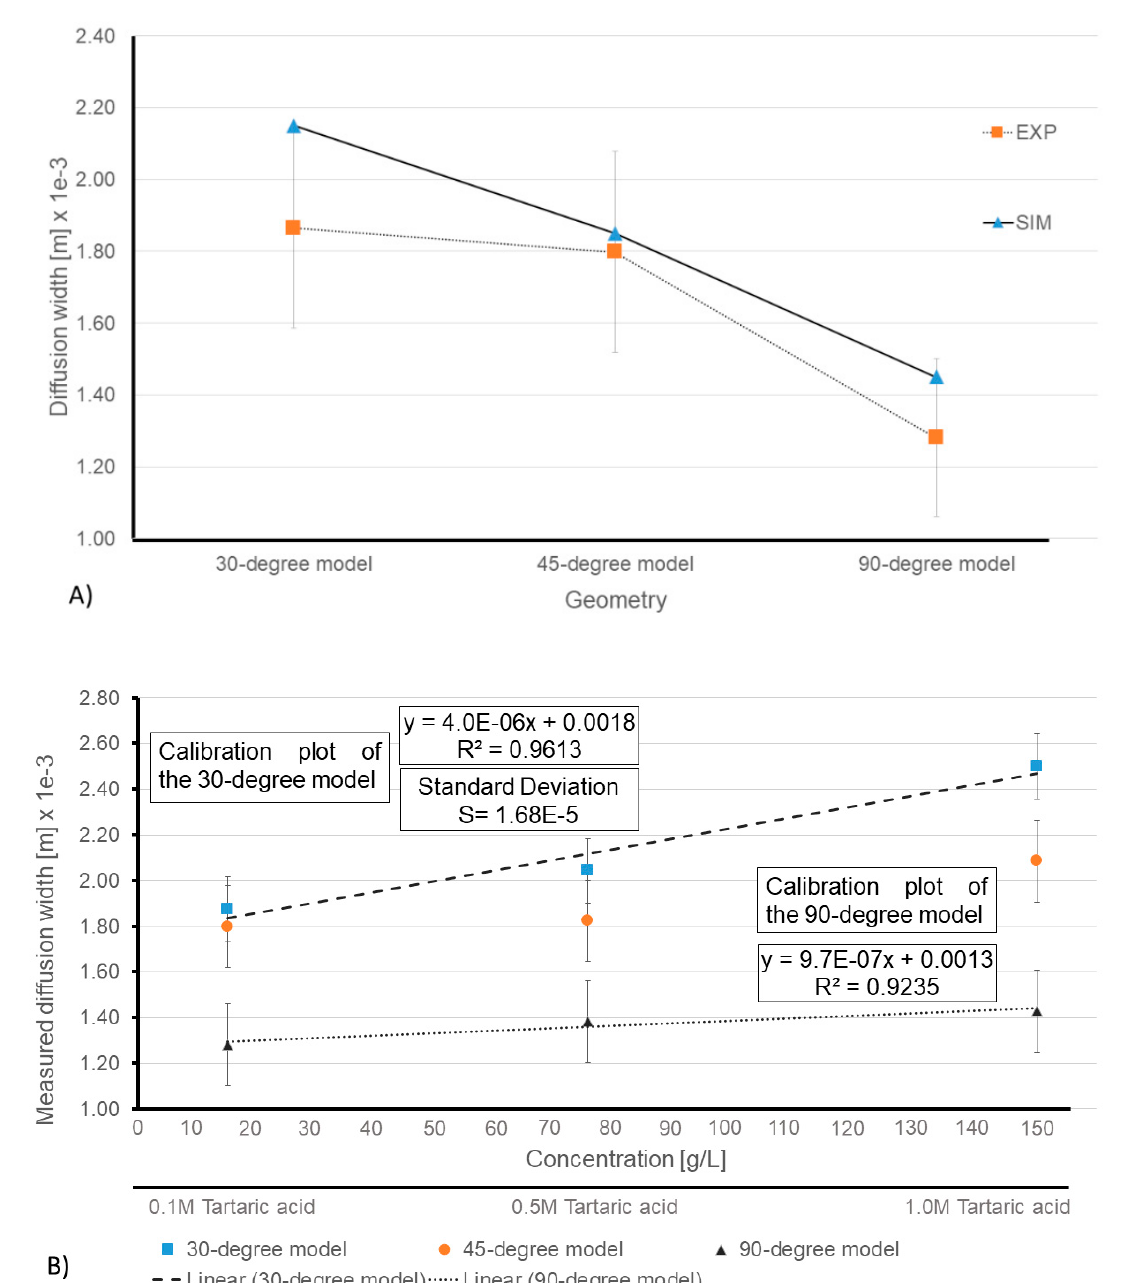
Figure 11. ( A ) Comparison between the diffusion widths in numerical results and the experiments. ( B ) Measured diffusion width based on the changes in the intensity of green channel and the calibration plots of the 30-degree and 90-degree models. Figure 11B displays the average reported diffusion widths in all the proposed models for the measured green color profile of the reagents (0.1, 0.5 and 1M tartaric acid). The X -axis is the concentration based on (g/L) unit, which was converted from the molar (M) unit (with respect to the molar mass of tartaric acid) and the Y -axis is the measured diffusion width based on the meter (m) unit, which was converted from the millimeter (mm) unit. Figure 11B clearly shows that the 30-degree model has a steeper regression line, and therefore, it is more sensitive to capture the differences between tartaric acid solutions. Meanwhile, the regression lines in the 45-degree and 90-degree are more grad- ual and demonstrate poor sensitivity. For instance, the 30-degree model displayed a 1.865 ± 0.28 mm and 2.478 ± 0.18 mm of diffusion width for the 0.1 M and 1.0 M